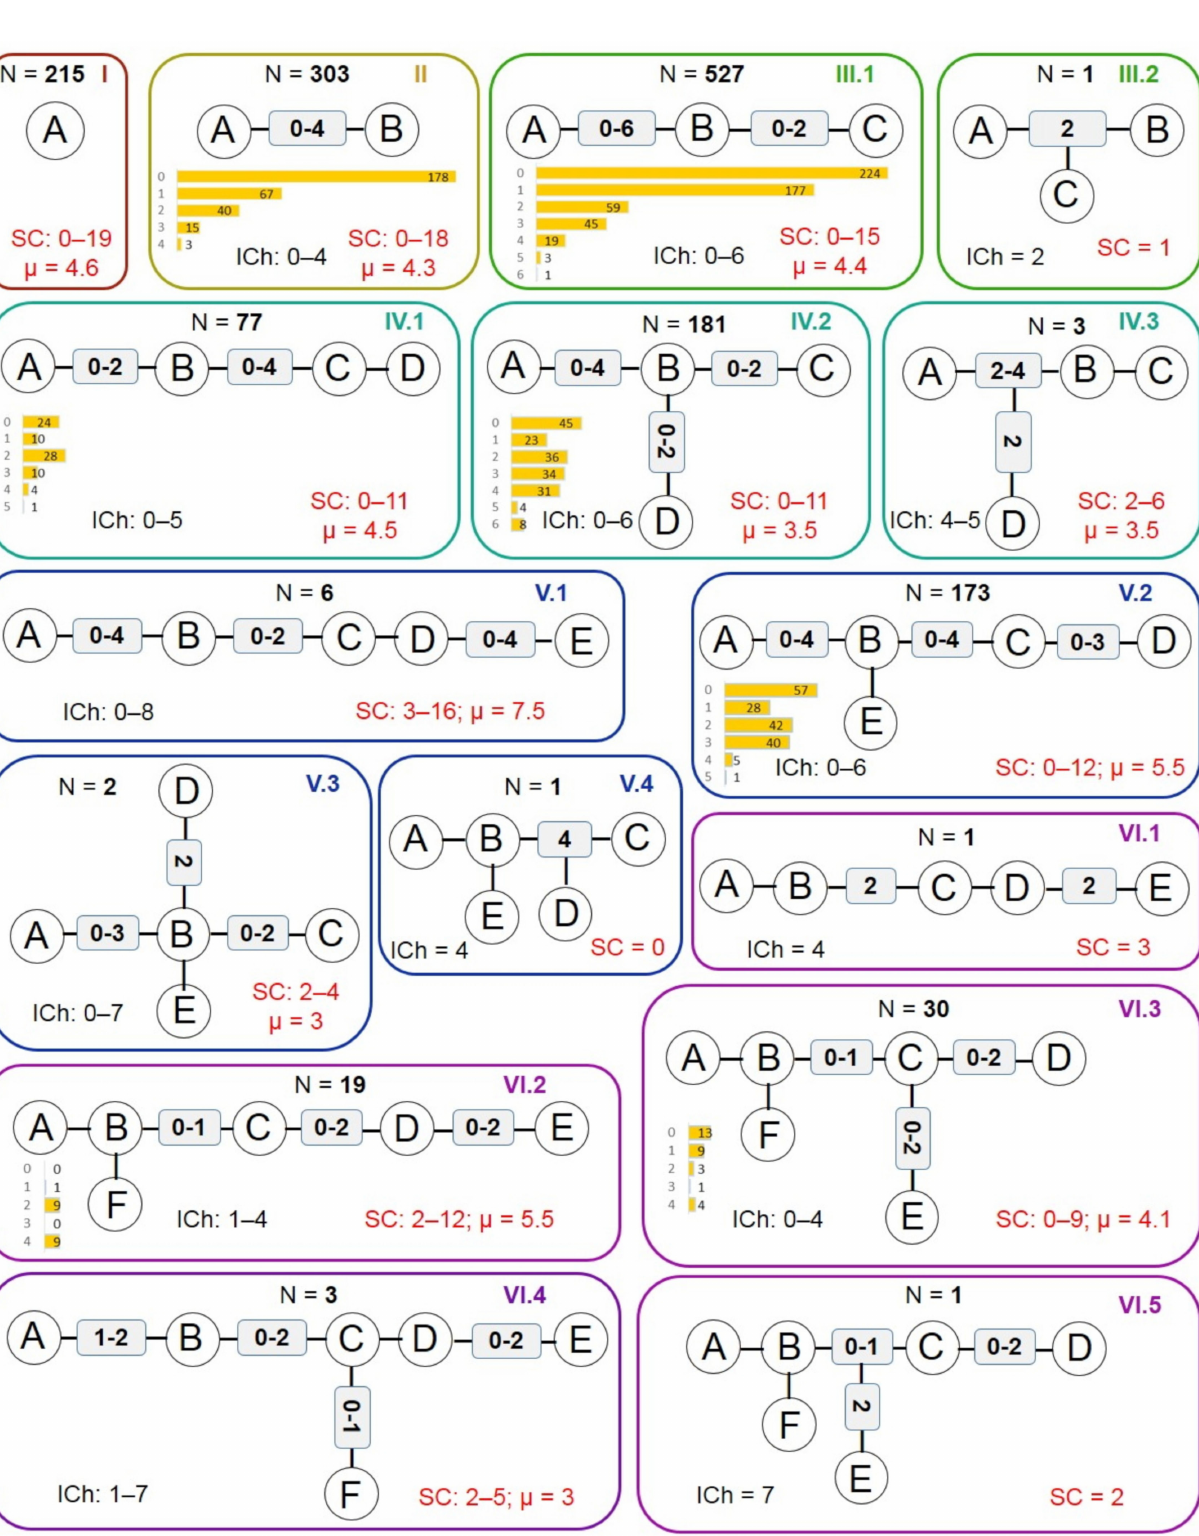
Figure 5. The architectural types of the BM skeletons. N represents the number of compounds in the data set that share each type. The distribution of the ICh values is presented as yellow bars; SC represents the dimension of the side chains and µ the average value across the BM